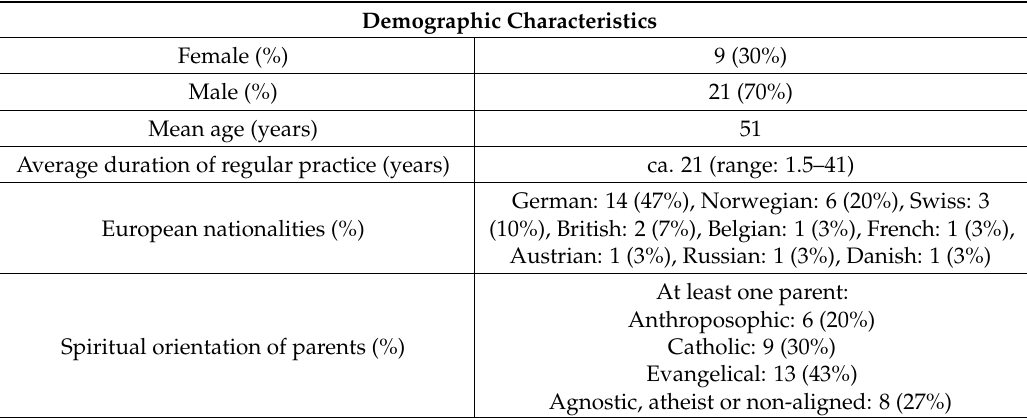
Table 1. Participants’